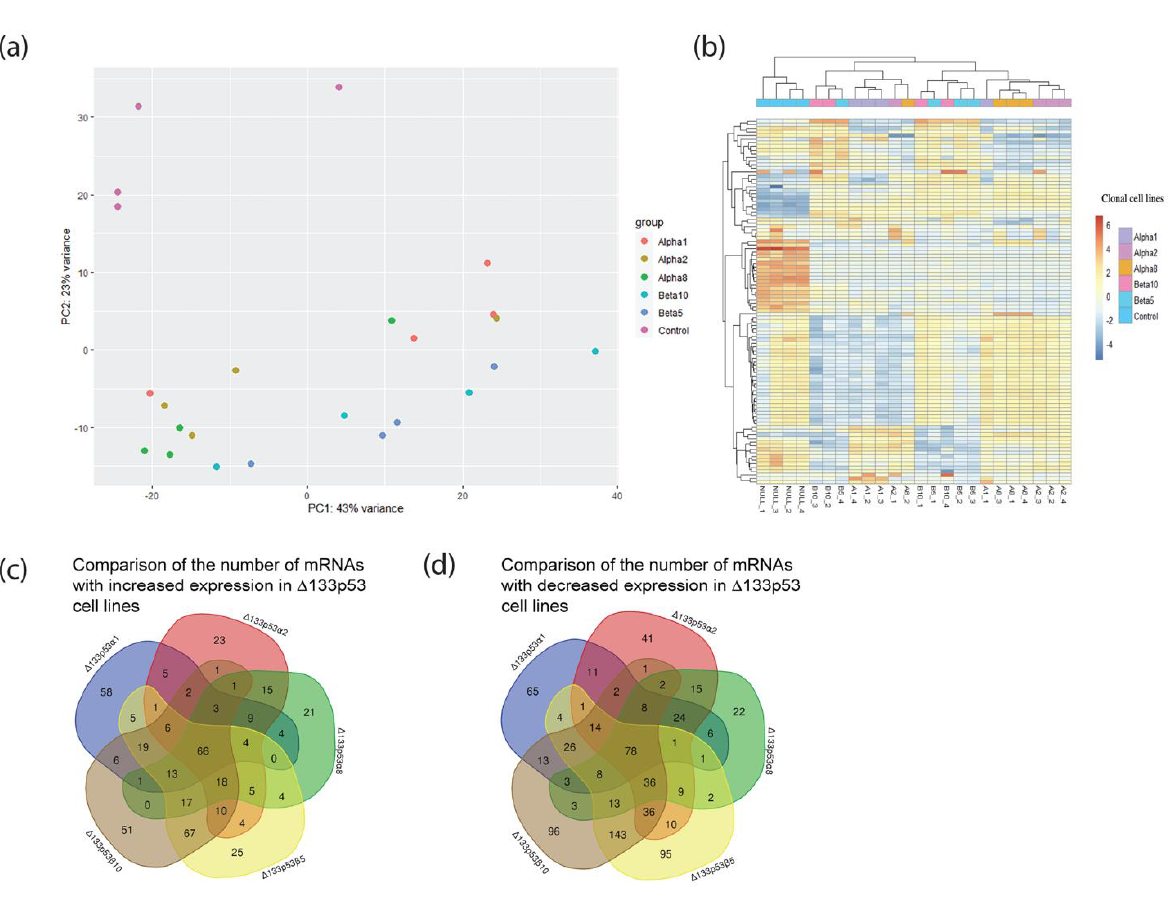
Figure 4. Introduction of Δ 133p53 α and Δ 133p53 β to H1299 cells resulted in distinct but overall subtle changes in gene expression. ( a ) Principal component analysis showing cell lines expressing Δ 133p53 α or Δ 133p53 β clustered distinctly from control cells without Δ 133p53 isoforms. ( b ) Top 200 most variable genes clustered control cells together, but not Δ 133p53 α or Δ 133p53 β cell lines. ( c ) Venn diagram of transcripts increased in Δ 133p53 α and/or Δ 133p53 β cell lines. ( d ) Venn diagram of transcripts decreased in Δ 133p53 α and/or Δ 133p53 β cell lines. Alpha 1, Δ 133p53 α 1; Alpha 2, Δ 133p53 α 2; Alpha 8, Δ 133p53 α 8; Beta 5, Δ 133p53 β 5; Beta 10, Δ 133p53 β 10; Control, H1299 p53 null.